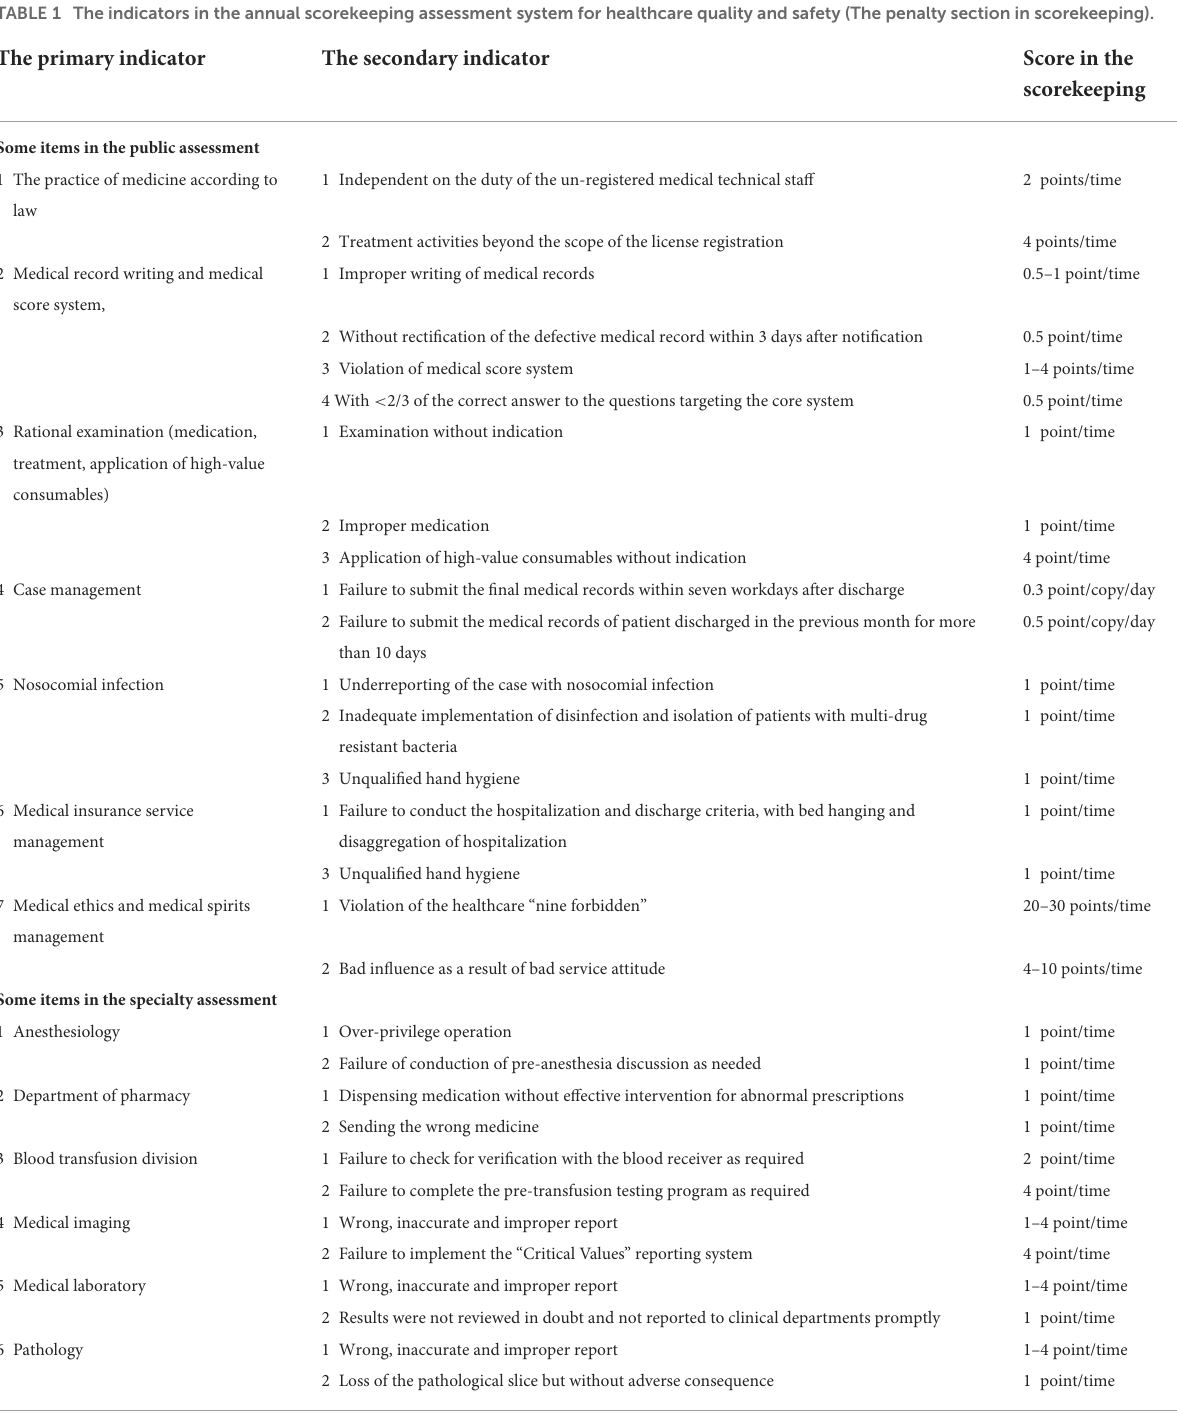
TABLE 1 The indicators in the annual scorekeeping assessment system for healthcare quality and safety (The penalty section in scorekeeping). The primary indicator The secondary indicator Score in the